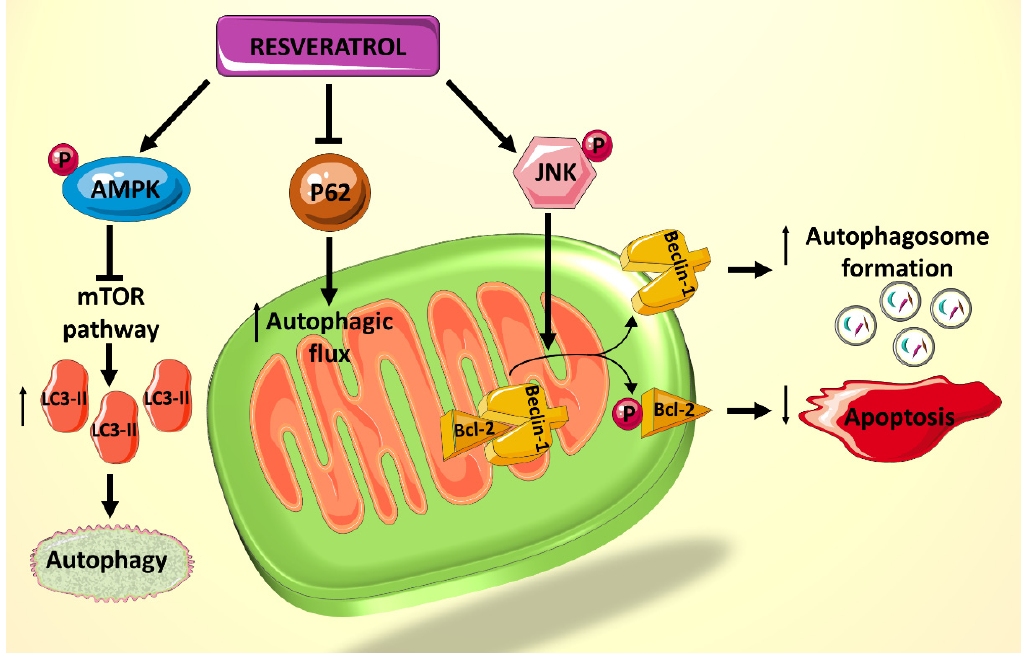
Figure 3. Summary of the effects of resveratrol on autophagy and apoptosis, mediated primarily by JNK1 and AMPK.